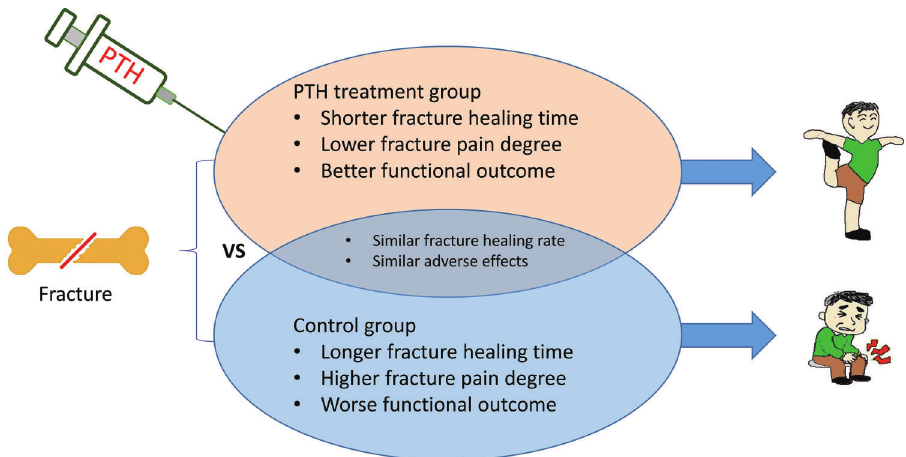
Figure 8 - Comparison of the effectiveness and safety of parathyroid hormone in fracture